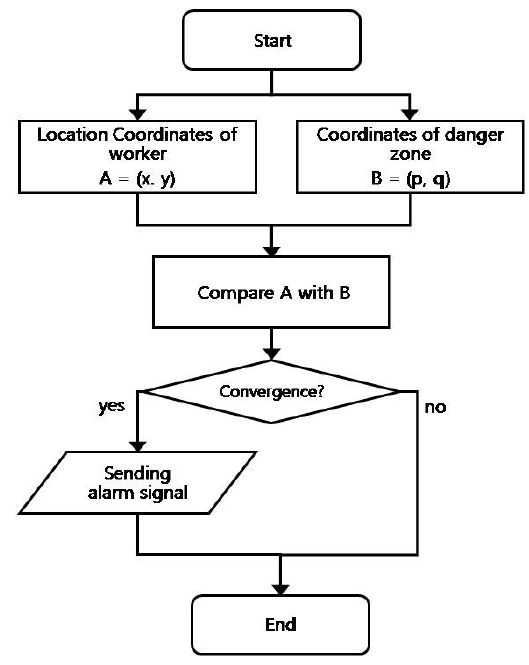
Fig. 4. Alarm signal transmission